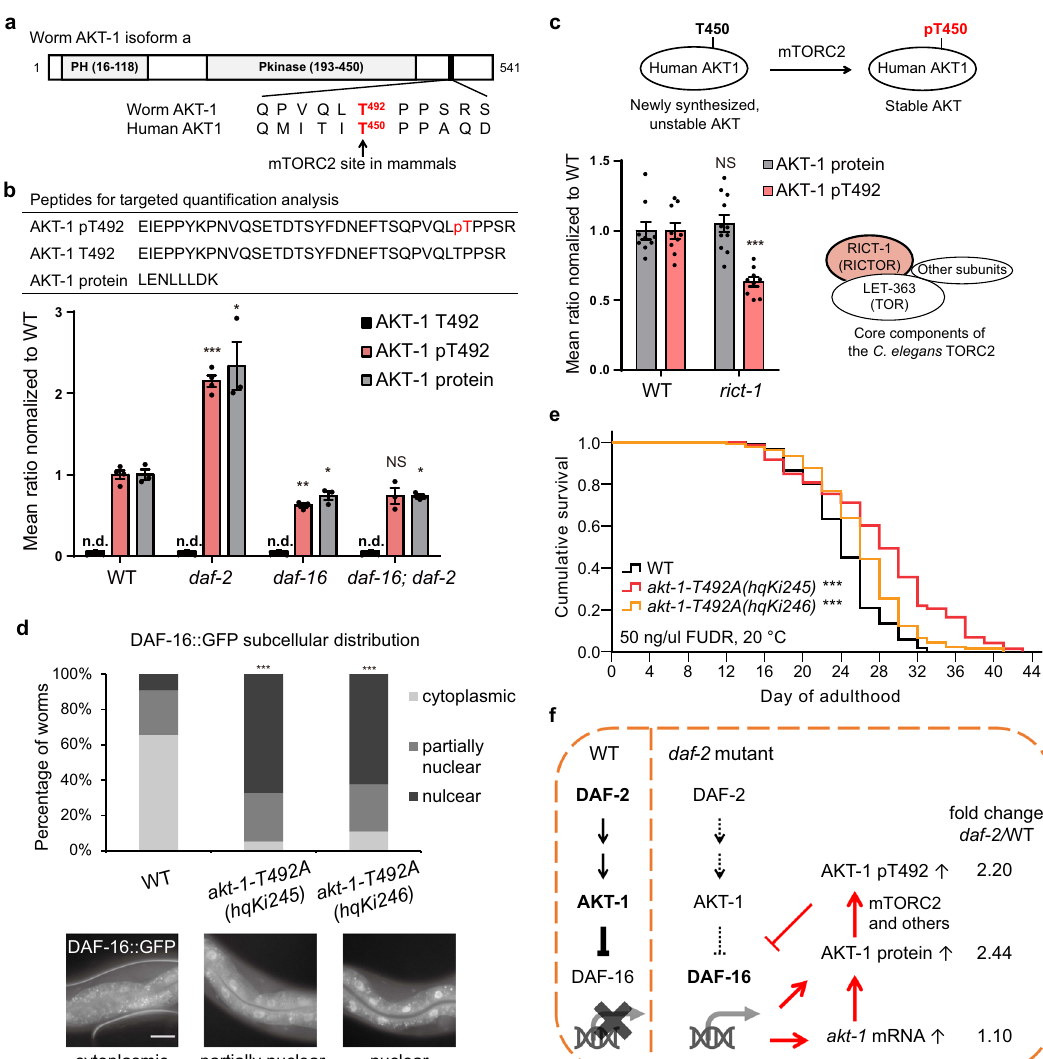
Fig. 3 Constitutive phosphorylation of AKT-1 T492 compensates for loss of daf-2 . a Schematic of the protein structure of worm AKT-1, isoform a. AKT-1 pT492 is conserved with human AKT1 pT450, an mTORC2 target site. Sequences were aligned via the UniProt website tool (https://www.uniprot.org/ align/). PH Pleckstrin Homology domain, Pkinase protein kinase domain. b Phosphorylation on AKT-1 T492 is constitutive. MS-based quanti fi cation of target peptides indicated that daf-2(lf) signi fi cantly enhanced the levels of both the AKT-1 pT492 and AKT-1 proteins, doing so in a DAF-16-dependent manner. In contrast, endogenous unphosphorylated AKT-1 T492 peptides were not detected. Peptides were quanti fi ed against isotopically labeled synthetic peptides spiked into whole-worm lysates. n.d. not detected. * p < 0.05, ** p < 0.01, *** p < 0.001, mutant versus WT, two-tailed Student ’ s t test, error bars denote the SEM. See statistics and biologically independent results in Source data. c AKT-1 T492 phosphorylation partially requires CeTORC2. Human AKT1 is phosphorylated on T450 and stabilized by mTORC2. MS-based target quanti fi cation showed that phosphorylation on AKT-1 T492 decreased by 40% in rict-1(ft7) worms, while AKT-1 protein levels were not affected. NS p = 0.57, *** p = 4.6e-5, mutant versus WT, two-tailed Student ’ s t test, error bars denote the SEM. Representative data from n = 3 independent experiments. See statistics in Source data. d AKT-1 T492A induced nuclear accumulation of DAF-16. Representative images show endogenous DAF-16::GFP cellular localization in intestinal cells of worms growing for 6 – 10 h after the L4 stage. *** p < 0.001, mutant versus WT, two-sided Fisher exact test. WT ( n = 64), hqKi245 ( n = 58), hqKi246 ( n = 64). Scale bar: 30 µ m. e AKT-1 T492A signi fi cantly extended the lifespan of C. elegans . *** p < 0.001, two-sided log-rank test, n > 70 worms per strain. Lifespan assays were performed at 20 °C, with 50 ng/ μ l FUdR supplied in plates. See survival statistics in Supplementary Dataset 4. f A model illustrates the IIS feedback regulation at the AKT-1 level. akt-1 mRNA data, from Son et al. 41